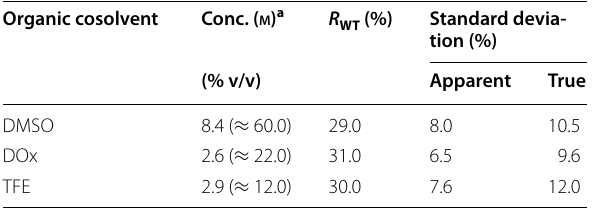
Conc. concentration, R WT residual activity of BSLA WT. Apparent and true standard deviation values for BSLA WT in the respective organic cosolvents, DMSO dimethyl sulfoxide, DOx 1,4‑dioxane, TFE 2,2,2‑trifluoroethanol a Concentration used in the incubation step for the BSLA activity assay